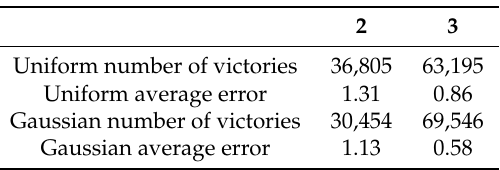
Table 2. Results for k = 2 vs. 3.